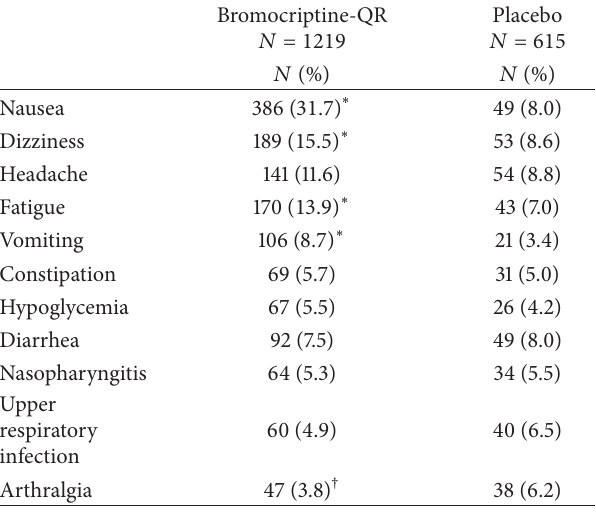
Table 4: Most commonly reported ( ≥ 5% in either treatment group) adverse